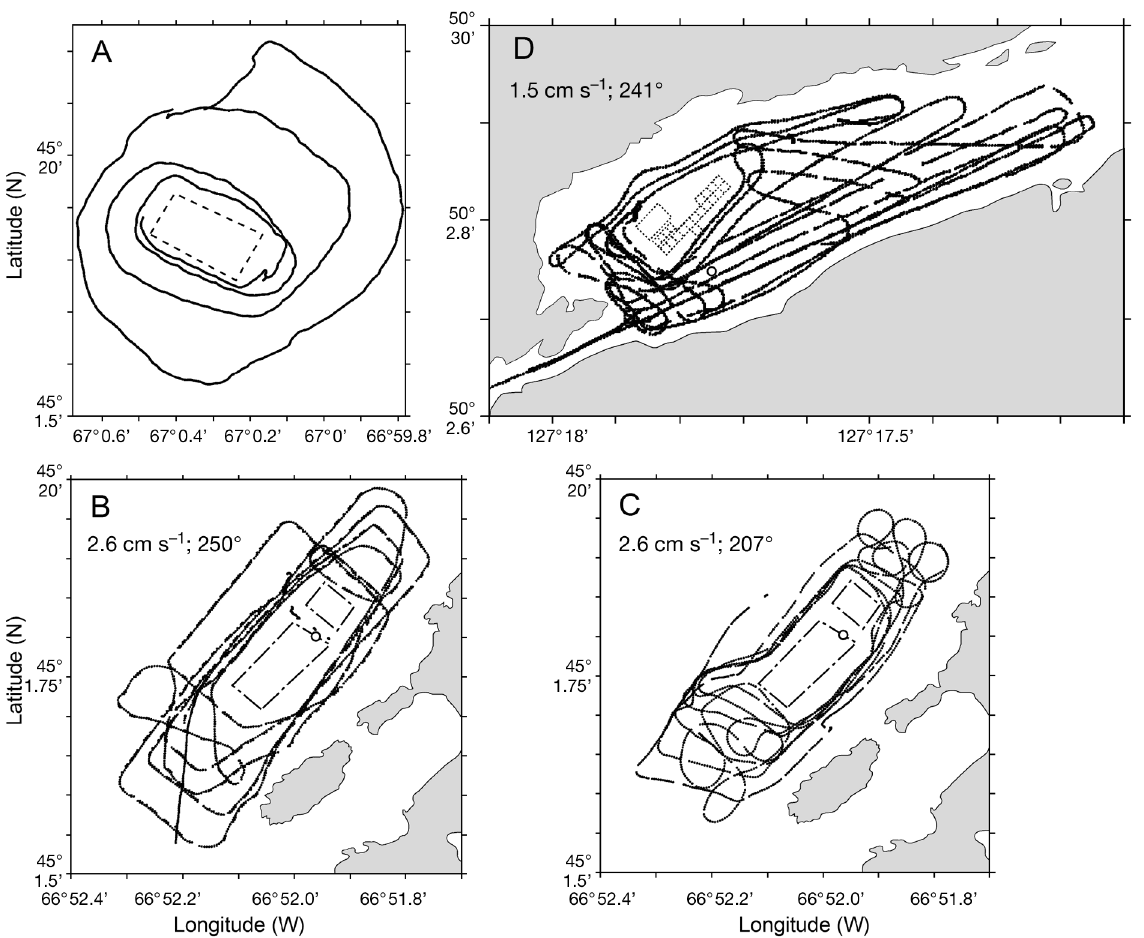
Fig. 2. Acrobat tow tracks (sampling points) outside farm boundaries at (A) Navy Island on 16 June 2010, (B) Charlie Cove on 5 July 2011, (C) Charlie Cove on 6 July 2011 and (D) Kyuquot Sound on 26 July 2011. Gaps in the tow path are due to the removal of data >0.5 m depth (see ‘Data analysis’). Farm boundaries are depicted by dashed/dotted lines. Average current speed and the prevailing direction over the survey period are provided, when available, and the current meter location is shown as open